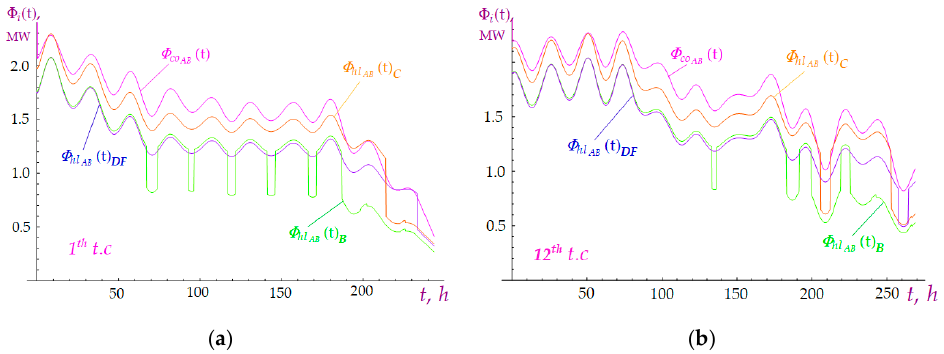
Figure 17. MP heating load Φ ( t ) and heating effect of MP cogeneration Φ co ( t ) for various commodities during 1st and 12th transport cycle for navigation ( a ) from A to B , and ( b ) B to A . Possible, short-term insufficiency of the double-stage cogeneration effect in balancing the generated heating load can easily be remedied by the short-term changing of microclimate parameters (relatively small increase in relative humidity, or a small reduction in the proportion of fresh air g fa ), as illustrated in Figure 18.